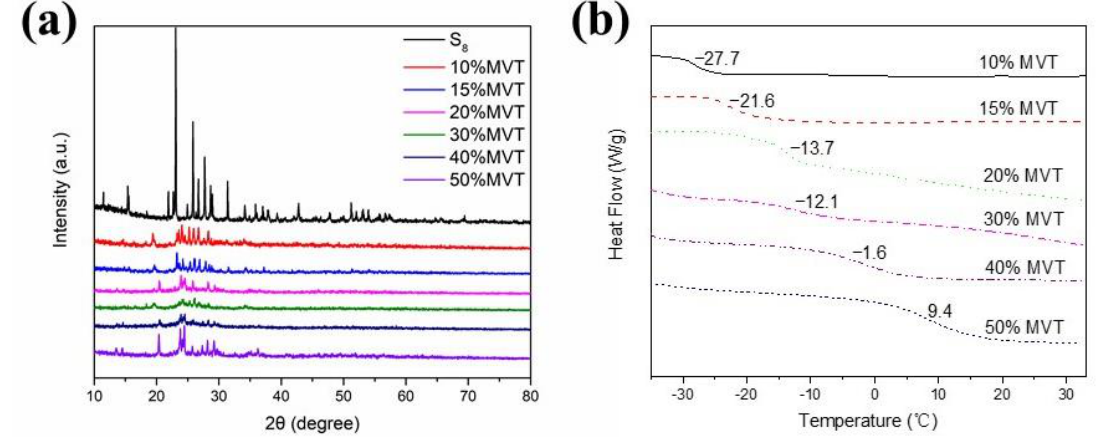
Figure 2. High-resolution ( a ) C1s, ( b ) S2p, and ( c ) N1s XPS spectra of poly(S-MVT) (15% MVT). The black curves are the experimental data, and the colored curves are deconvolution fits. ( d ) Proposed partial structure of protonated poly(S-MVT).